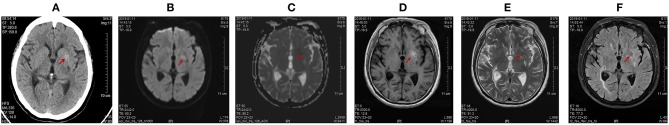
Computed tomography (CT) of the brain on January 15, 2019 and magnetic resonance imaging (MRI) of the brain on January 11, 2019. Abnormal signals were marked by red arrow. (A) The unenhanced high-density axial CT images within the left lentiform nucleus. The range of this abnormal signal was about 11.4 mm * 10.6 mm, and the CT value was 50.7 Hu. (B) The left lentiform nucleus showed a slightly high signal intensity by diffusion weighted imaging (DWI). (C) The left lentiform nucleus showed an equal signal intensity on ADC images. The ADC value of the abnormal lesion center was 0.636 * 10−3 mm2/s. (D) The left lentiform nucleus with a high signal intensity on T1-weighted MR images. The range of this abnormal signal is about 21 mm * 11 mm. (E) The left lentiform nucleus showed a low signal intensity on T2-weighted scans. (F) The left lentiform nucleus indicated a low signal intensity on fluid-attenuation inversion recovery (FLAIR) sequences.